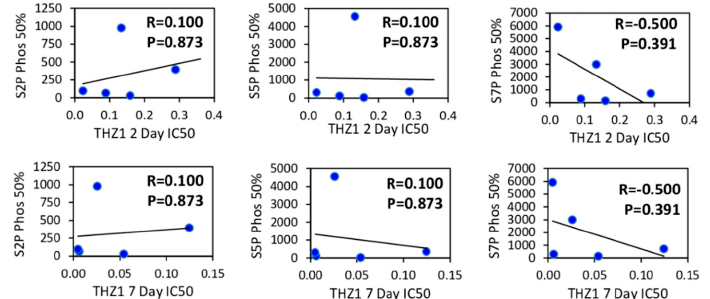
Figure 7. Effect of THZ1 on phosphorylation of RNA Pol II does not correlate with THZ1 sensitivity. Using densitometric analysis of RNA Pol II S2P, S5P, S7P levels the concentration of THZ1 required to decrease the phosphorylation of each protein to 50% relative to control cells was calculated and expressed as an IC 50 value. The S2P, S5P and S7P IC 50 values were examined for potential correlations